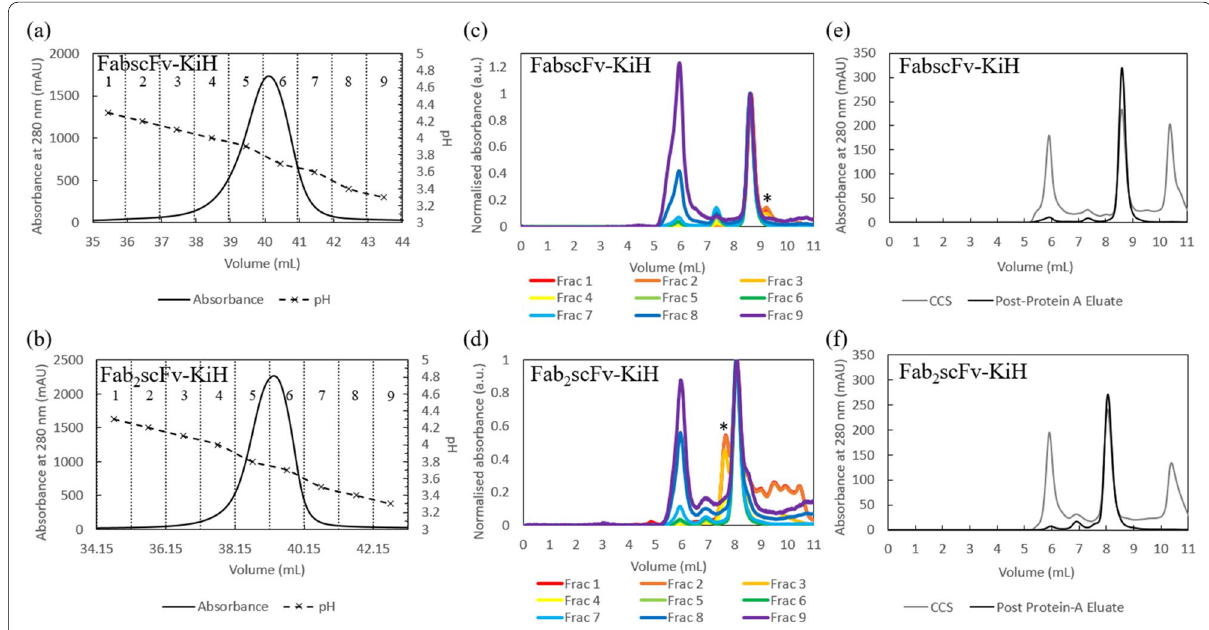
Fig. 2 AKTA chromatograms and HPLC-SEC chromatograms of elute fractions of MabSelect PrismA runs. AKTA chromatogram of FabscFv-KiH ( a ) and Fab 2 scFv-KiH ( b ), with a pH gradient elution from pH 6.0 to pH 3.0 in 25 CV using MabSelect PrismA resin. The pH values indicated here represent the pH of each fraction measured by an external pH probe, with each fraction number indicated at the top of the chromatogram. HPLC-SEC chromatogram of FabscFv-KiH ( c ) and Fab 2 scFv-KiH ( d ) of each fraction of the eluates with absorbance values normalized to that of the monomeric peak, where each absorbance value was divided by the highest absorbance value of the monomeric peak. The likely hole–hole homodimeric mispaired products are indicated with*. The purity profile of the pooled post-Protein A eluate of all 9 fractions with respect to the CCS is also illustrated for FabscFv-KiH ( e ) and Fab 2 scFv-KiH ( f